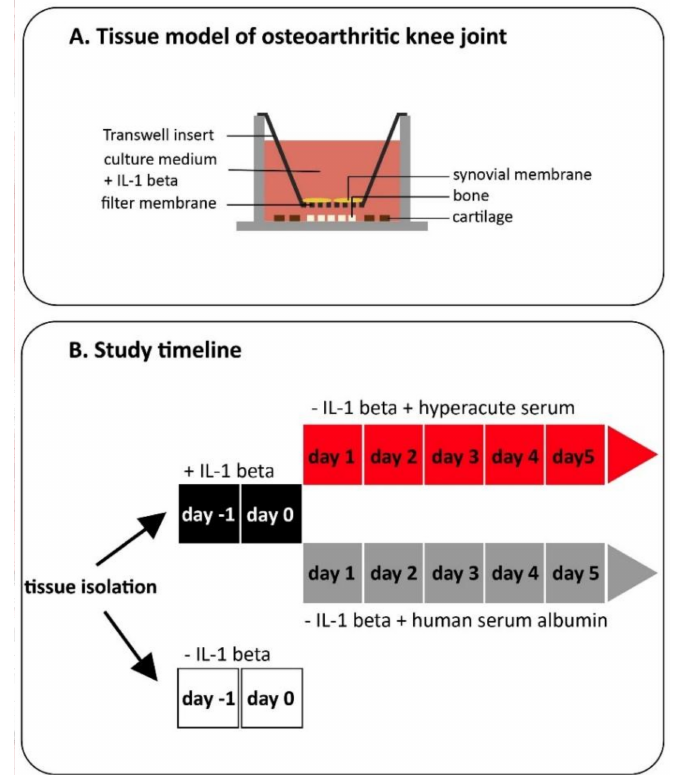
Figure 2. Design of the experiment. Our in vitro knee tissue co-culture model was built from the three main tissue types (i.e., synovial membrane, subchondral bone, and hyaline cartilage), which play roles in the pathogenesis of OA. The structure of the model allows similar communication pathways as it happens in vitro. ( A ) After building the model, tissues were stimulated by IL-1 β for 2 days or cultured without IL-1 β as a negative control. Medium was exchanged in the IL-1 β -stimulated cultures and tissues were treated with 10% hyperacute serum for 5 days. We used human serum albumin with a matched albumin content as a negative control for 5 days ( B